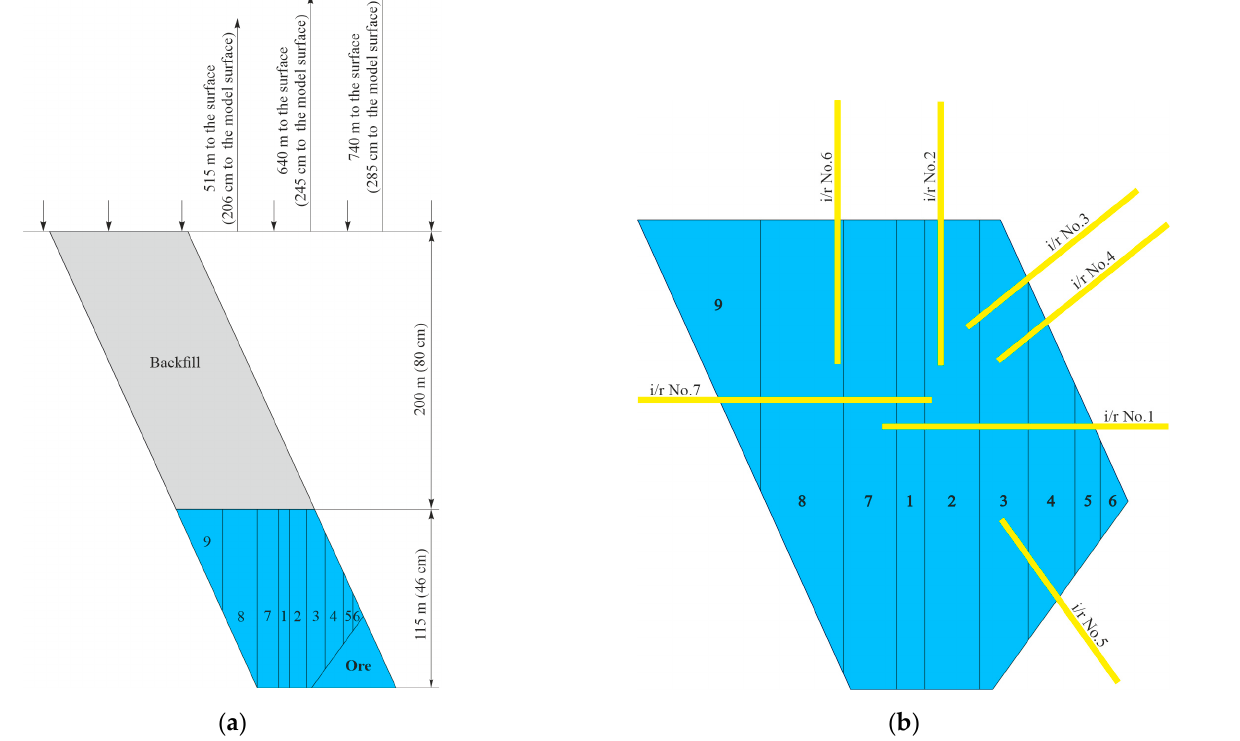
Figure 4. Scheme of the model and the order of mining the stopes in stages ( a ) and the scheme for arranging the indicator rulers when mining the stopes ( b ).